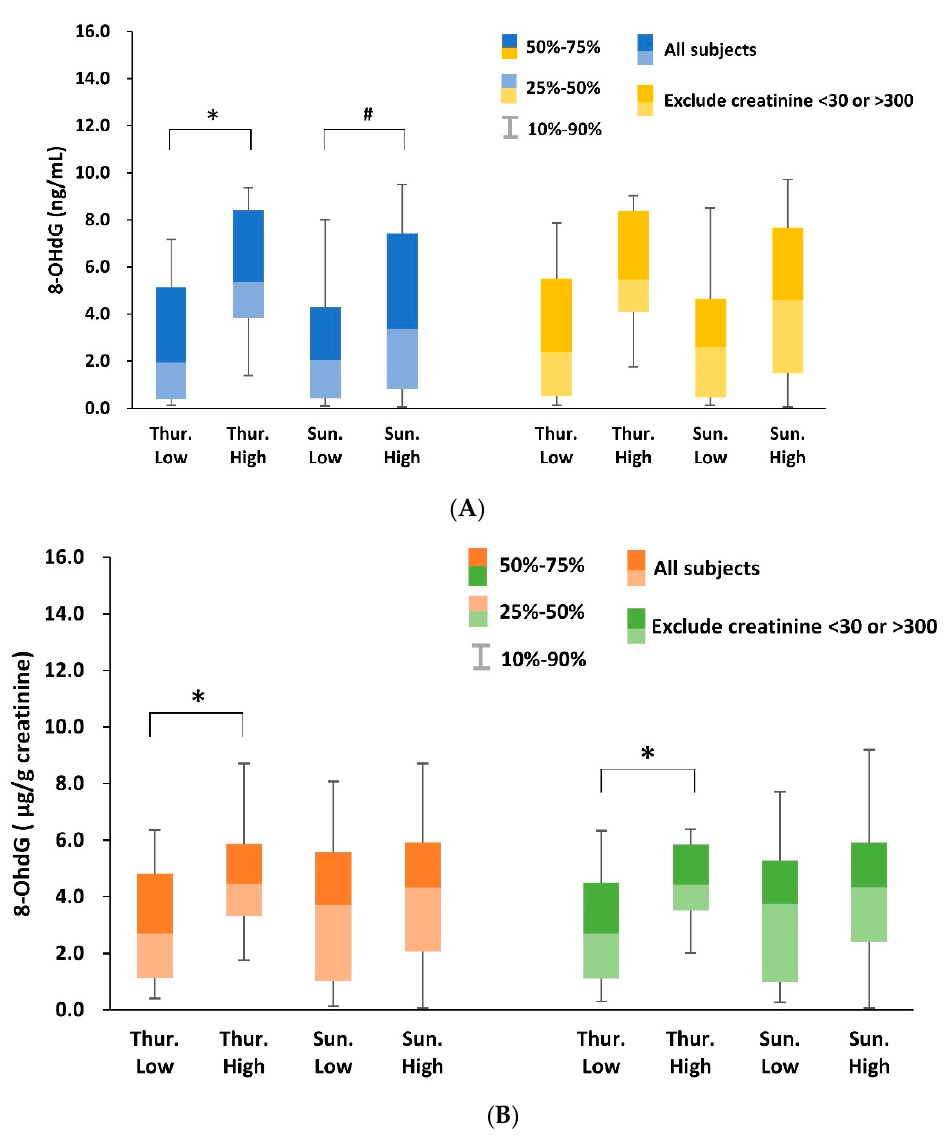
Figure 1. Oxidative stress analytical results grouped by Co-Exposure index integrating ZnO and TiO 2 NPs showing in ( A ) ng/mL and ( B ) μ g/g creatinine. # p < 0.1; * p < 0.05